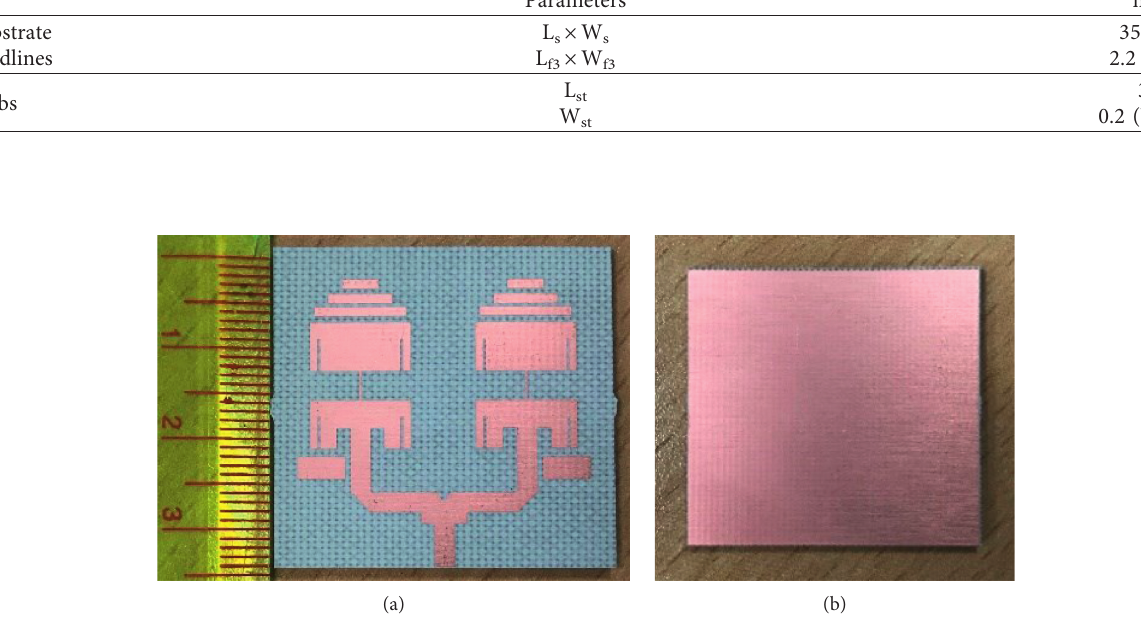
Table 4: Dimensions of the proposed corporate-series-fed array antenna. Parameters